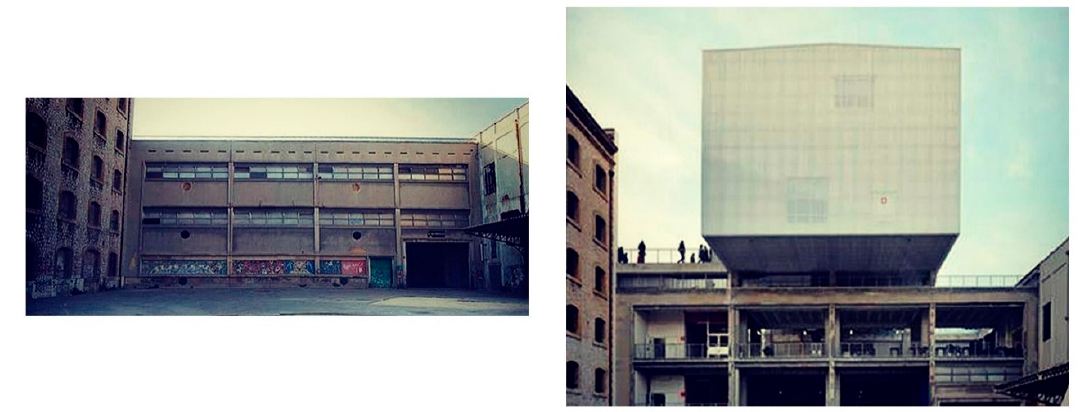
Figure 2. Two images from La friche instagram account. The pictures represent the same place before and after the architectural intervention by Patrick Bouchain and Mathieu Poitevin